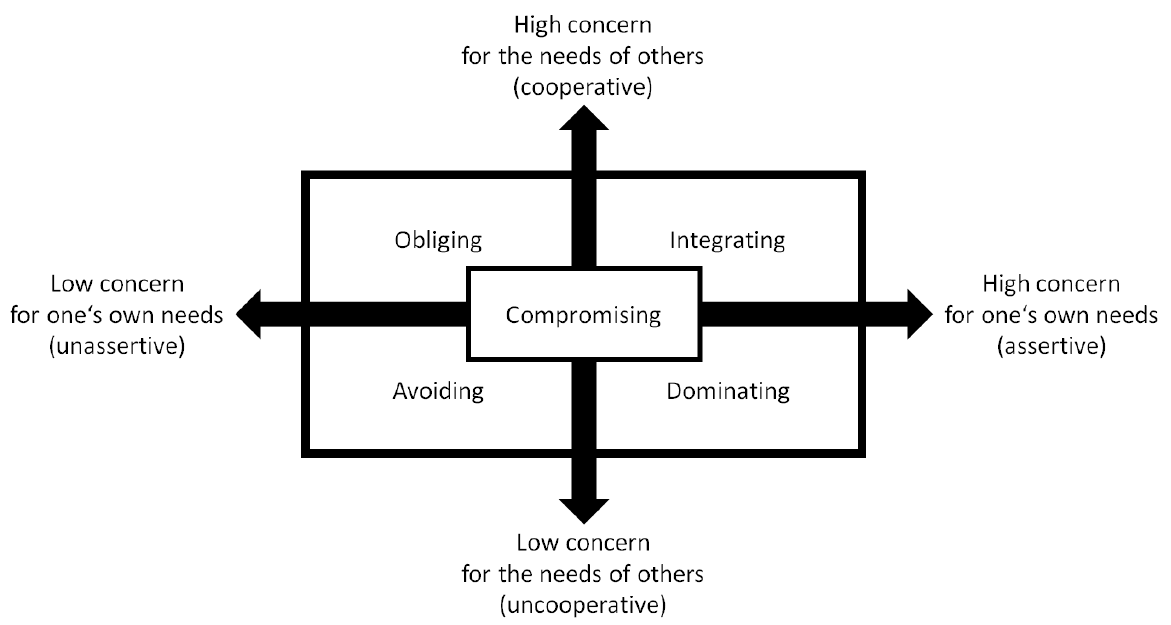
Figure 1. A schematic visualization of the two continua generating a fourfold table of conflict management styles.